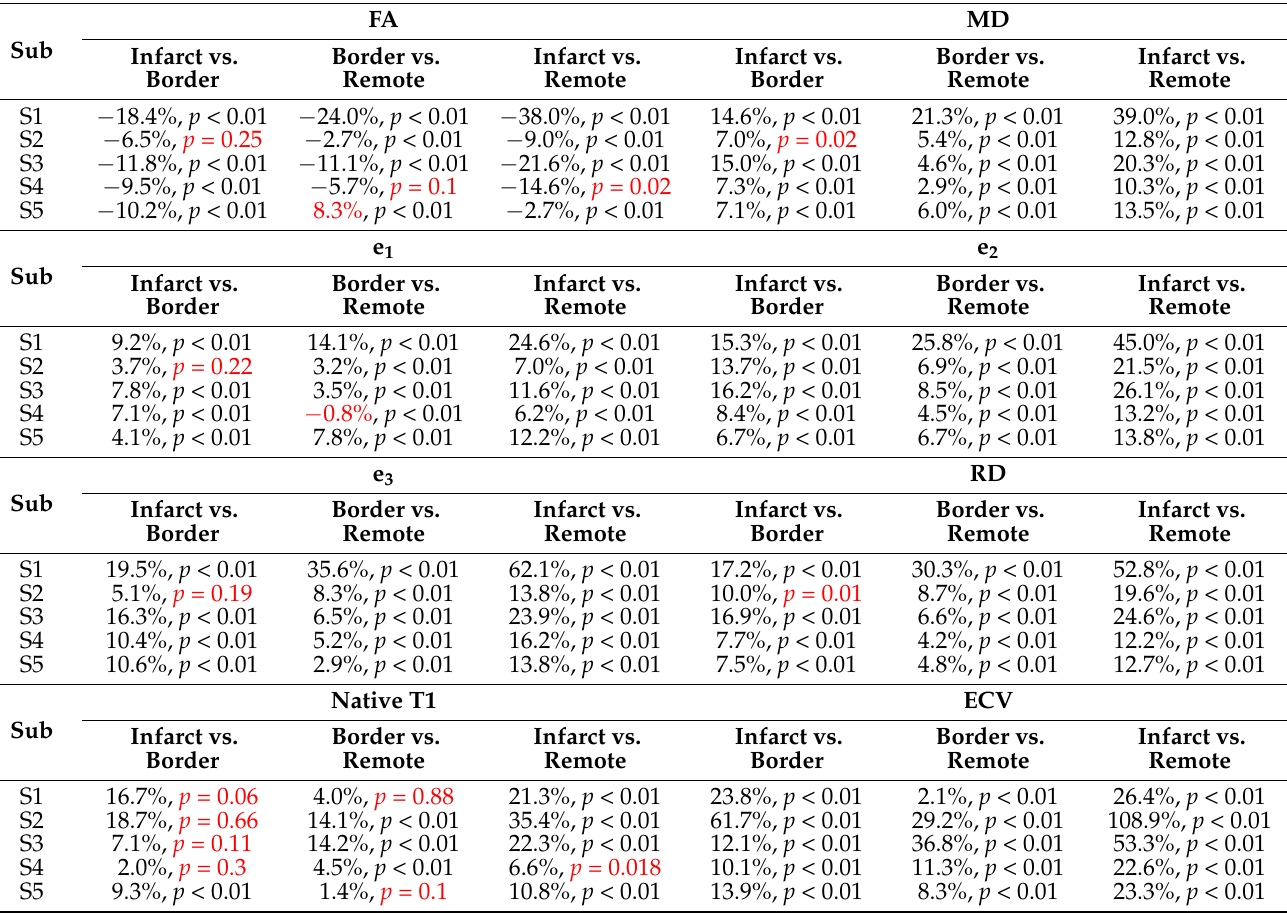
Table 3. Median value percentage change and p -values resulting from non-parametric pairwise Kruskal–Wallis test between infarct–border, border–remote, and infarct–remote regions for each subject separately and for all measured quantities. Values reported in red correspond to p -values greater than or equal to 0.01 or isolated cases where percentage changes are opposite to the overall observed